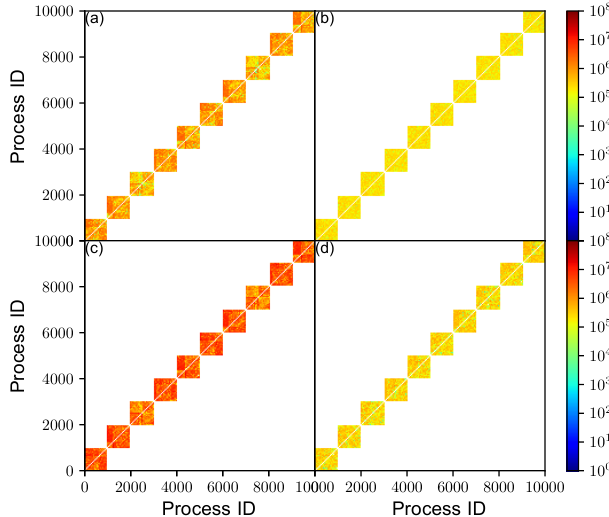
Figure 7. Congestion of transposition using (a) minimal routing algorithm for the dragonfly-MM topology, (b) valiant routing algo- rithm for the dragonfly-MM topology, (c) ugal routing algorithm for the dragonfly-MM topology, and (d) minimal routing algorithm for the dragonfly-SL topology.